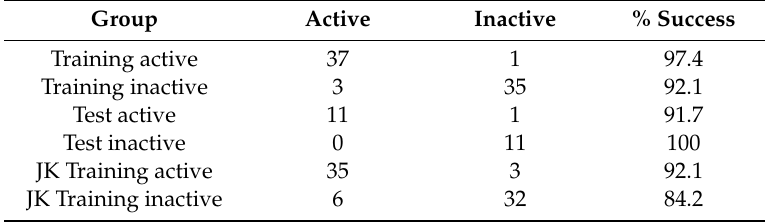
Table 2. Classification matrix for DF2.